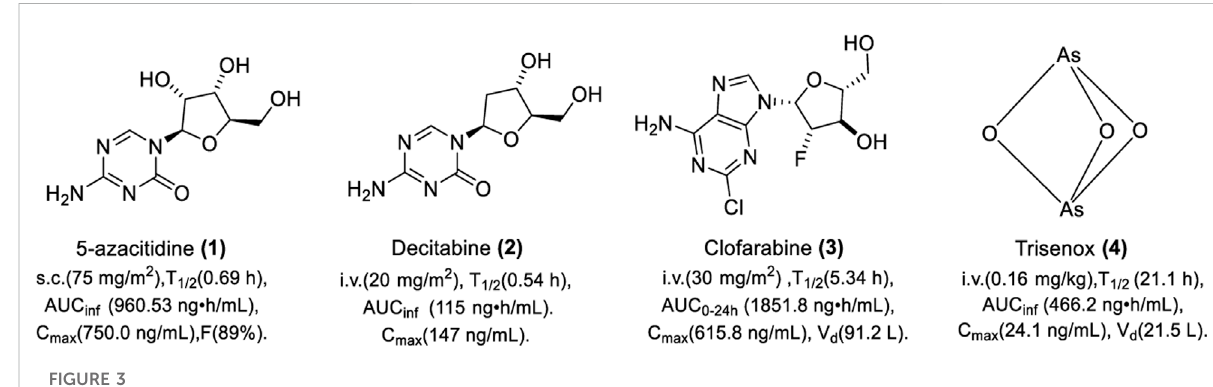
FIGURE 3 Chemical structure of DNMTis approved by the